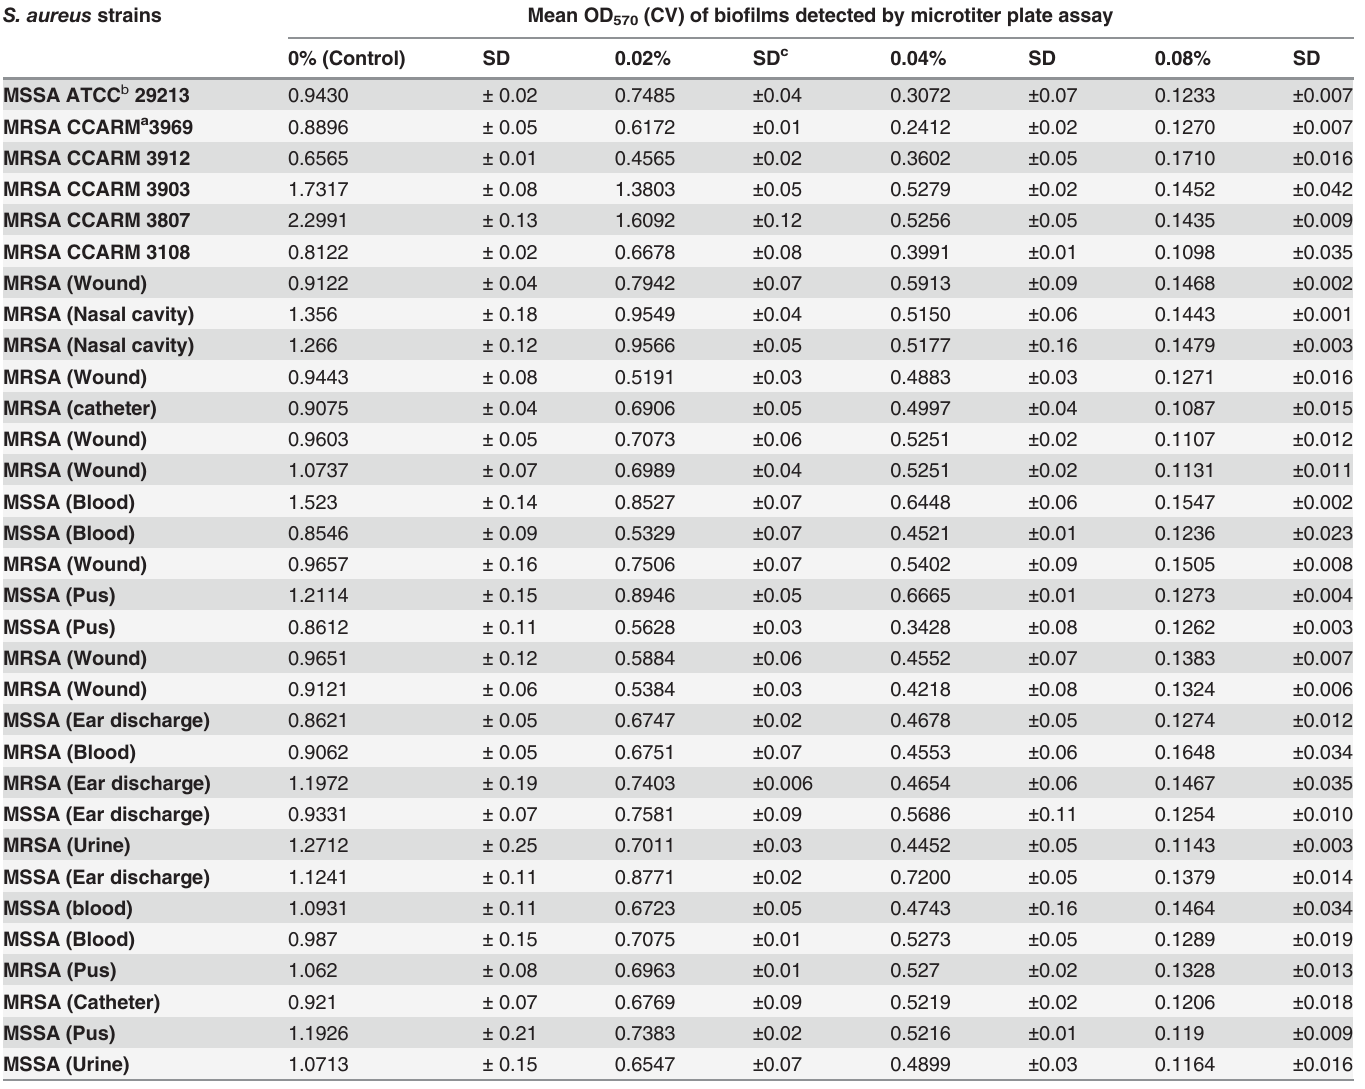
Table 2. Effect of eugenol on the eradication of established bio fi lms of MRSA and MSSA clinical strains. S. aureus